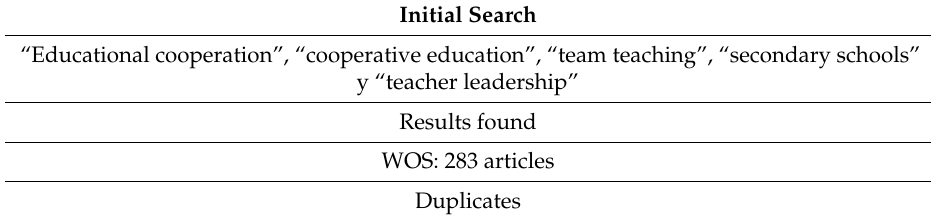
Table 1. Sample selection process.